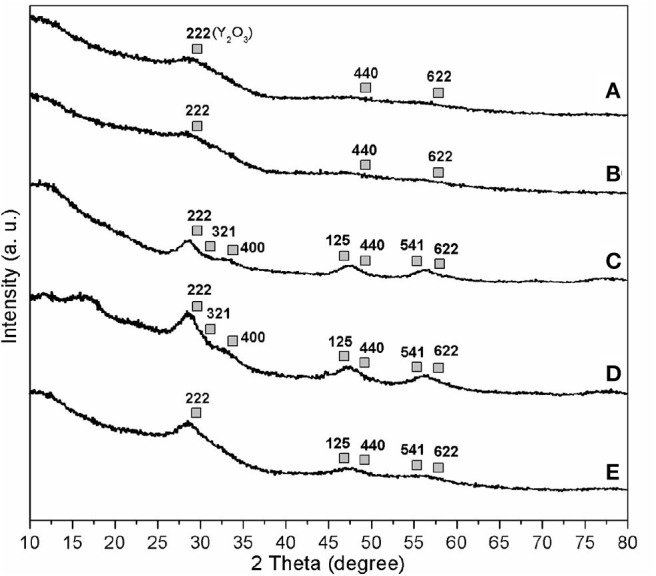
Wide-angle XRD patterns of powdered (A) C1, (B) C2, (C) C4, (D) C1g, and (E) C4g.